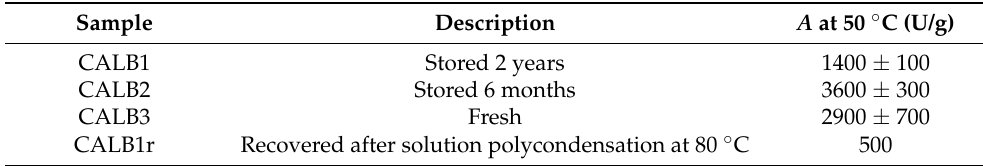
Table 1. Activities of the Candida antarctica Lipase B (CALB) samples N435 employed as catalyst for